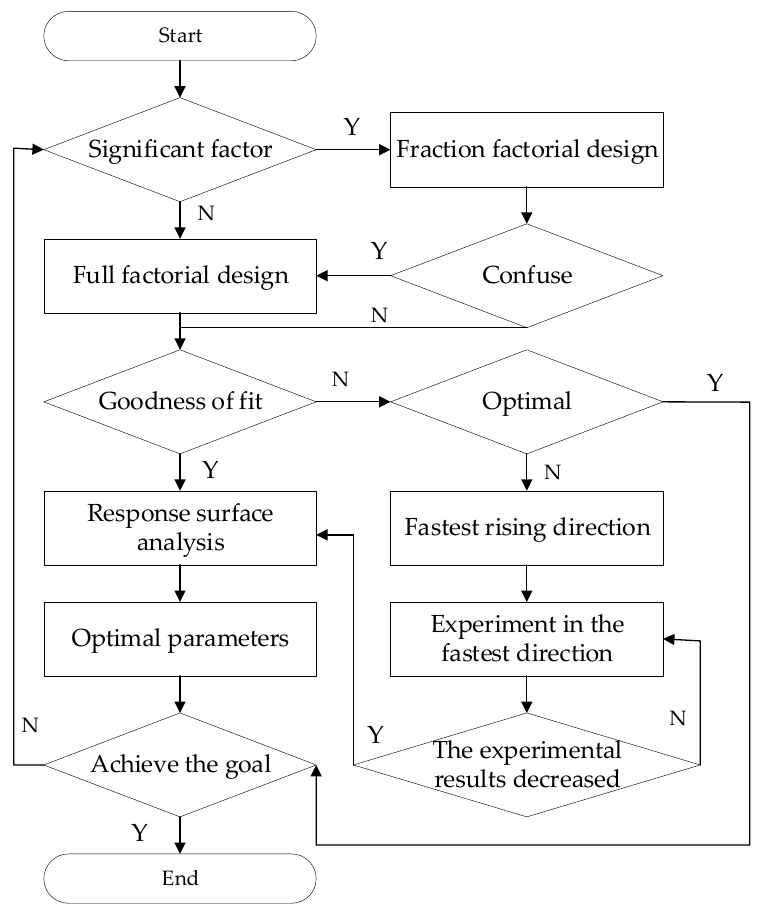
Figure 8. General flow of experimental design.